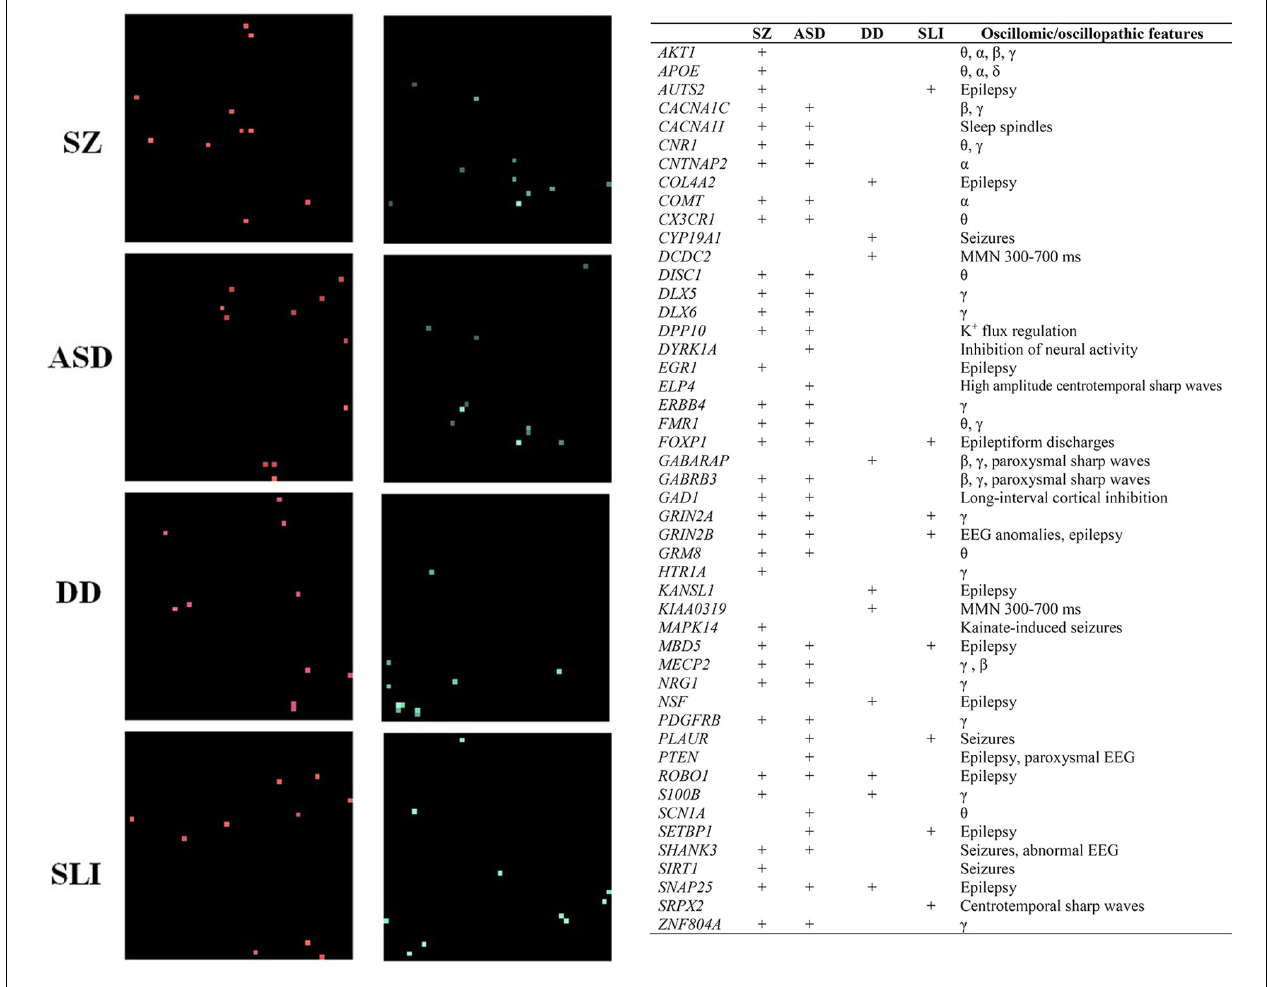
FIGURE 4 | The “Why” Question. Genes involved in brain rhythmicity are expected to exhibit a disorder-specific expression profile in the brain of affected people. The figure shows the expression grids of genes involved in brain rhythmicity that are also candidates for four prevalent conditions involving problems with language: schizophrenia (SZ), autism spectrum disorder (ASD), developmental dyslexia (DD) and specific language impairment (SLI). The grids were generated with Enrichr (amp.pharm.mssm.edu). Each grid square represents a brain region in the Allen Brain Atlas (portal.brain-map.org). Brain regions where genes of interest are upregulated are displayed in red (the brighter the square, the more upregulated the gene is in the selected region). Regions in which genes are downregulated are shown in green (the brighter the color, the more downregulated the gene is). The genes considered in the analysis, which can be regarded as robust candidates for the language oscillogenome, are displayed in the table, with an indication of their role in brain rhythmicity (adapted from Murphy and Benítez-Burraco, 2018a; Figure 2 and Table